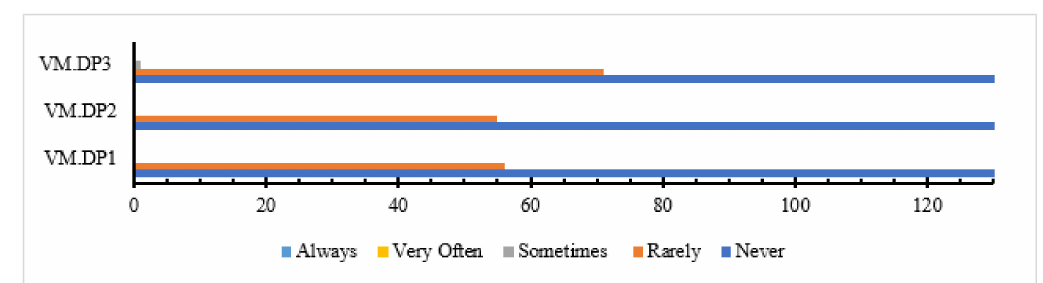
Figure 8. Frequency distribution for the evaluation phase.